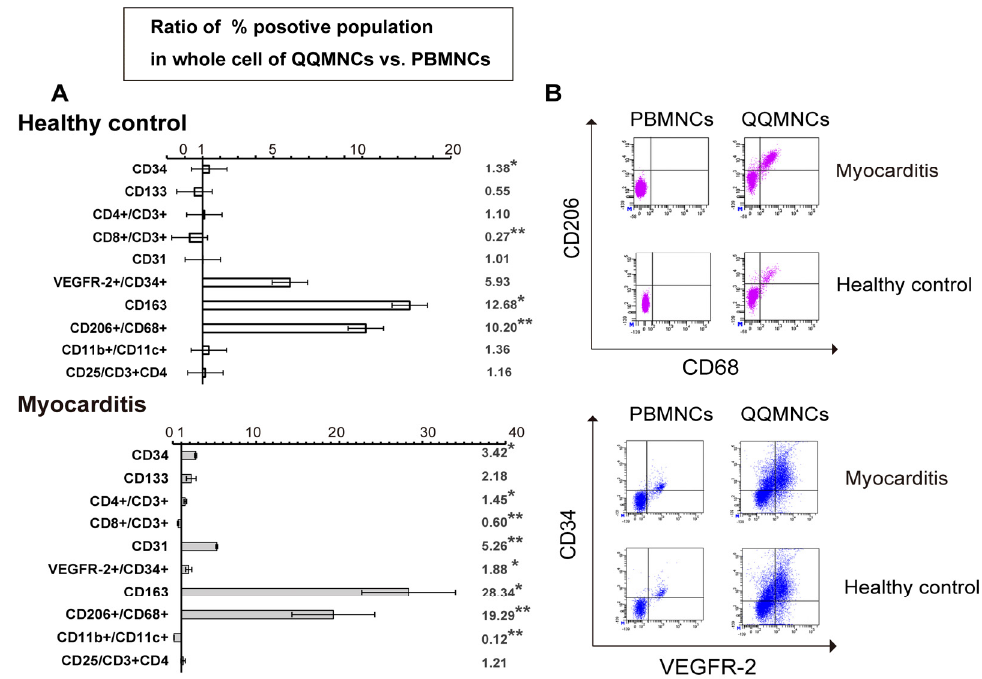
Figure 3. Flow cytometry analysis of QQMNCs derived from rats with EAM. ( A ) The upper bar graph in healthy control shows the ratio of each (%) cell positivity in QQMNCs relative to that in PBMNCs. The lower bar graph in EAM shows the ratio of each (%) cell positivity in QQMNCs relative to that in PBMNCs. The investigated cell surface markers were as follows: hematopoietic stem cell (CD34, CD133), endothelial cell (VEGFR-2+/CD34, CD31), T cell (CD3, CD4, CD8), dendric cell (CD11b/c), monocyte (CD68), M2 macrophage (CD163, CD206/CD86), and regulatory T cell (CD25/CD3+CD4). ( B ) FCM was performed on gated PBMNCs and QQMNCs (gated CD68, CD206, VEGFR-2, and CD34). Data shown as mean ± SE. N = 6, * p < 0.05, ** p < 0.01. VEGFR: vascular